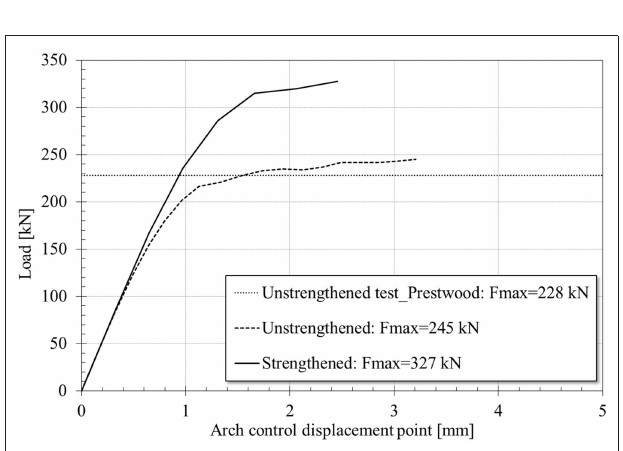
FIGURE 9 | Numerical Load-Arch displacement control point curve (unstrengthened and strengthened conditions) and experimental maximum applied load (unstrengthened condition) for Prestwood bridge (Page, 1987).